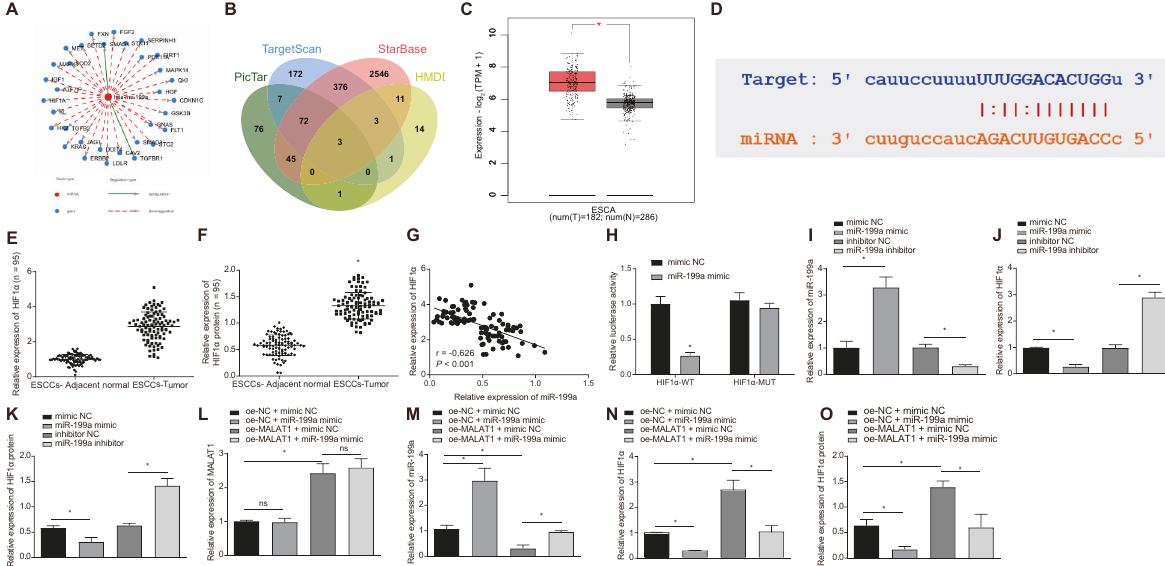
Fig. 5 MALAT1 enhanced HIF1 α expression through binding to miR-199a. A Network diagram of target genes of miR-199a based on bioinformatics website HMDD. B Venn diagram of the target genes of miR-199a predicted by HMDD, PicTar, TargetScan and starBase websites. C A box plot of HIF1 α expression in ESCC samples. D The binding site of miR-199a and HIF1 α predicted by the starBase website. E , F The expression of HIF1 α mRNA and protein in tumor tissues (ESCC-Tumor group) and adjacent normal tissues (ESCC-Adjacent normal group), as measured by qRT-PCR and Western blot. n = 95 in ESCC patients. G Correlation analysis of miR-199a expression and HIF1 α mRNA expression in tumor tissues of 95 ESCC patients analyzed by Pearson correlation analysis. H Dual luciferase reporter assay was employed to examine the binding between miR-199a and HIF1 α mRNA. I The miR-199a expression was examined by qRT-PCR in KYSE150R cells in response to miR-199a mimic or miR-199a inhibitor. The mRNA and protein expression of HIF1 α measured by qRT-PCR ( J ) and Western blot ( K ) in KYSE150R cells in response to miR-199a mimic or miR-199a inhibitor. L The MALAT1 expression measured by qRT-PCR in KYSE150R cells in response to miR-199a mimic and oe-MALAT1 alone or in combination. M The miR-199a expression in KYSE150R cells in response to miR-199a mimic and oe-MALAT1 alone or in combination examined by qRT-PCR assay. The mRNA and protein expression of HIF1 α in KYSE150R cells in response to miR-199a mimic and oe-MALAT1 alone or in combination examined by qRT-PCR ( N ) and Western blot ( O ). * p < 0.05, compared with adjacent normal tissues, mimic NC group, inhibitor NC group, oe-NC + mimic NC group, or oe-MALAT1 + mimic NC group. Measurement data were showed as mean ± standard deviation. Data between tumor tissues and adjacent normal tissues were compared by paired t test. The other two group comparison was analyzed by unpaired t test. Data of multiple groups were compared by one-way ANOVA with Tukey ’ s post-hoc test. Cell experiments were repeated three